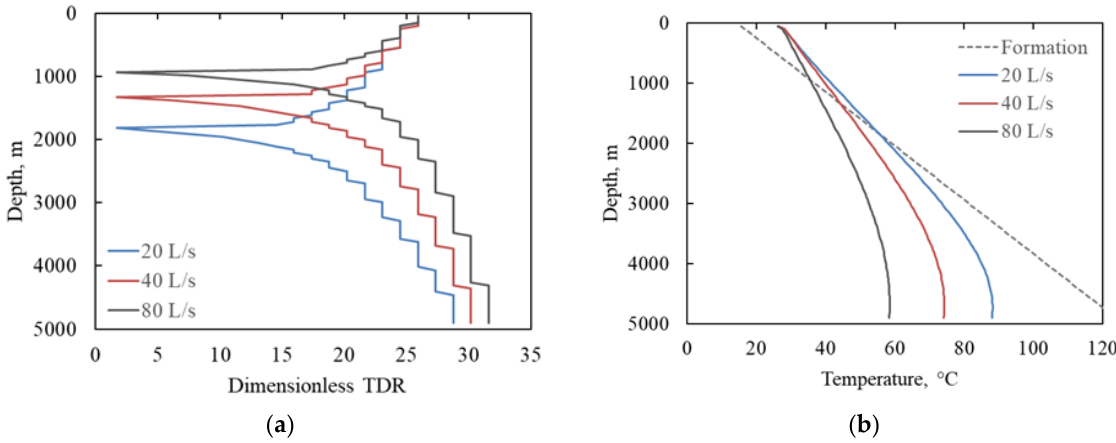
Figure 7. The sensitivity analysis of thermal disturbance with various circulation rates: ( a ) TDR and